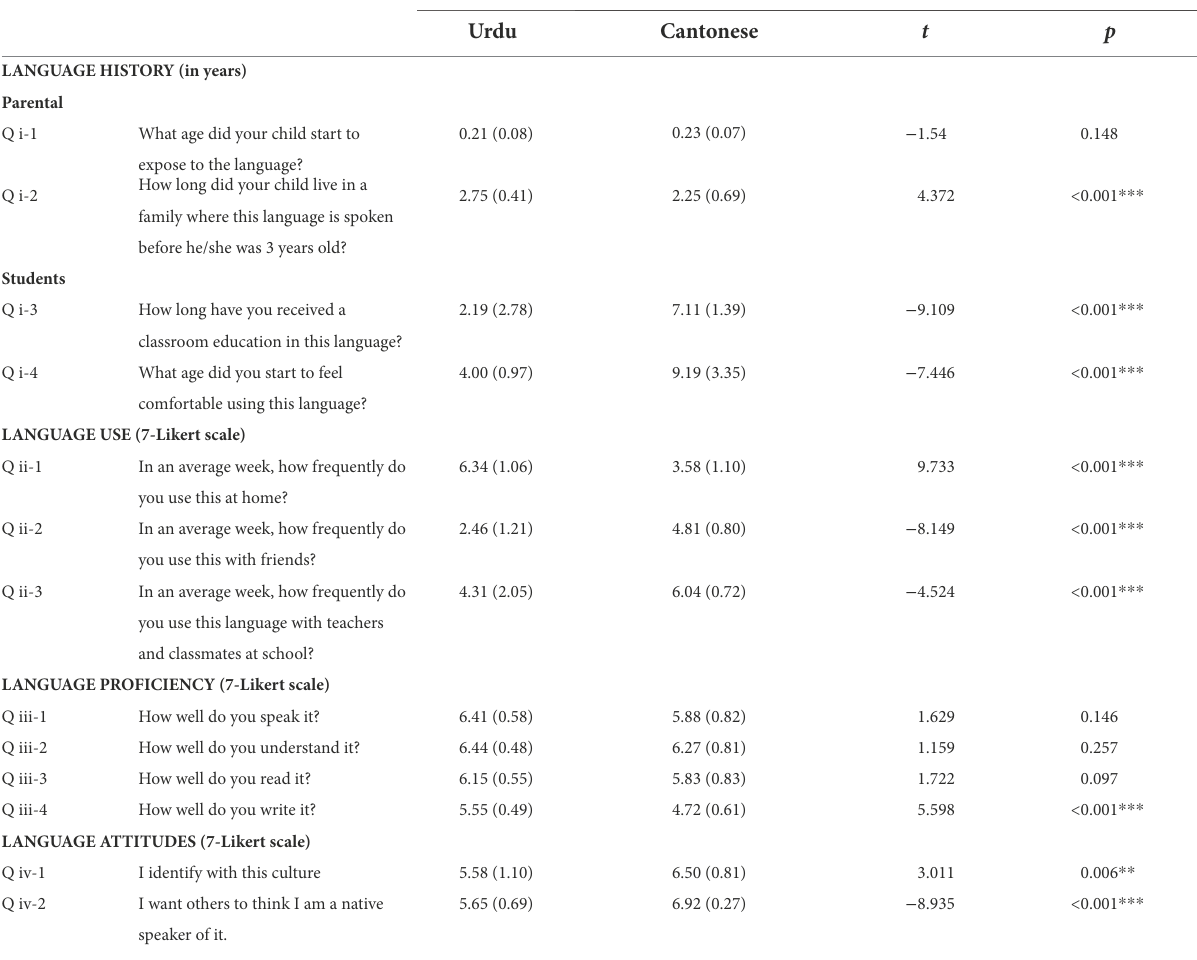
TABLE 1 Main results of parental and students’ questionnaires (revised from Birdsong et al., 2012). Question